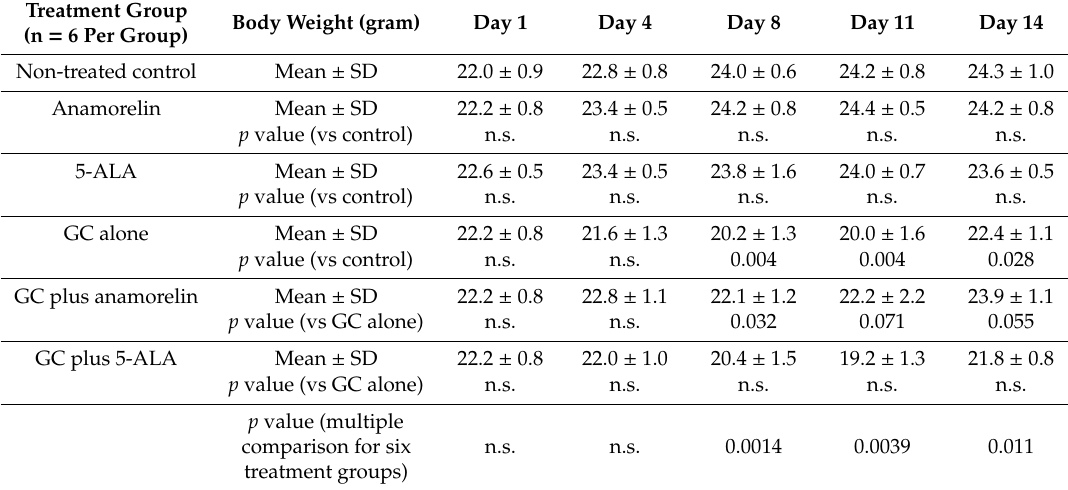
Table 1. Change in body weight during the treatment.